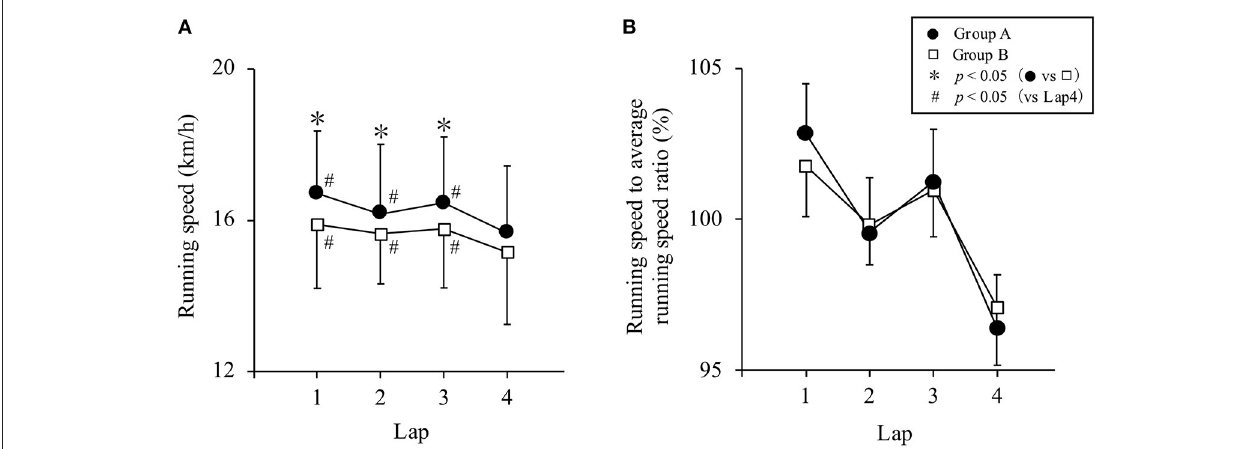
FIGURE 2 | Difference in time between the athletes who passed each point first. The first pack of Group A is designated as “a” and the second pack as “b,” while the first pack of Group B is designated as “c” and the second pack as “d” at the split time. Data are presented as individual values.